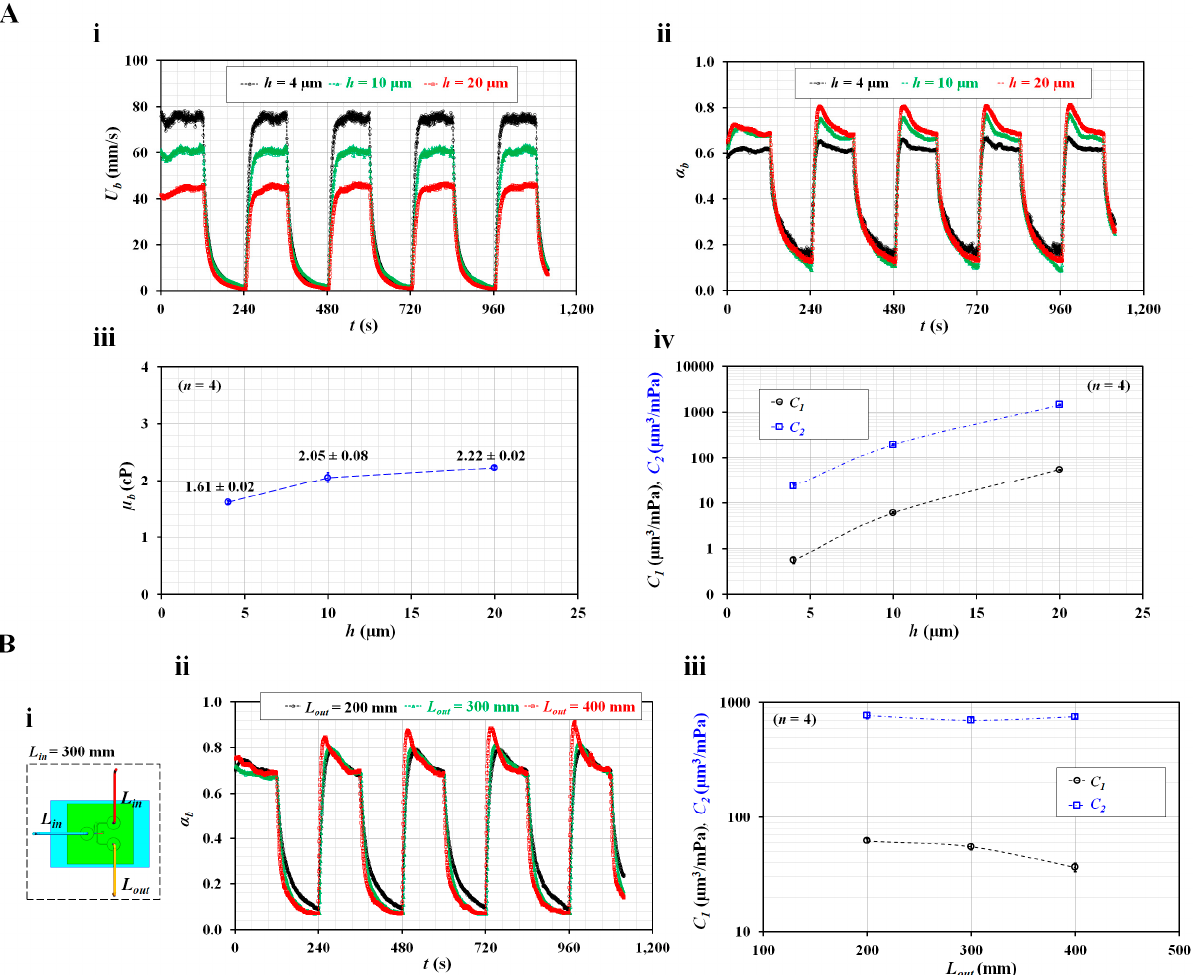
Figure 4. Contributions of channel depth ( h ) and outlet tubing length ( L out ) to blood viscosity ( µ b ) and two compliances ( C 1 and C 2 ). Blood (Hct = 50%) was prepared by adding normal RBCs into autologous plasma. ( A ) Contribution of channel depth ( h ) to two compliances ( C 1 and C 2 ). ( i ) Temporal variations of blood velocity ( U b ) with respect to channel depth ( h ) ( h = 4, 10, and 20 µ m). ( ii ) Temporal variations of interface ( α b ) with respect to h . ( iii ) Variations of blood viscosity ( µ b ) with respect to h . ( iv ) Variations of two compliances ( C 1 and C 2 ) with respect to h . ( B ) Contribution of outlet tubing length ( L out ) to two compliances ( C 1 and C 2 ). ( i ) Schematic of a microfluidic device connected with three kinds of tubing. L in and L out represent the length of inlet tubing and length of outlet tubing. The length of inlet tubing was fixed at L in = 300 mm. The length of outlet tubing set to L out = 200, 300, and 400 mm. ( ii ) Temporal variations of interface ( α b ) with respect to h . ( iii ) Variations of two compliances ( C 1 and C 2 ) with respect to L out